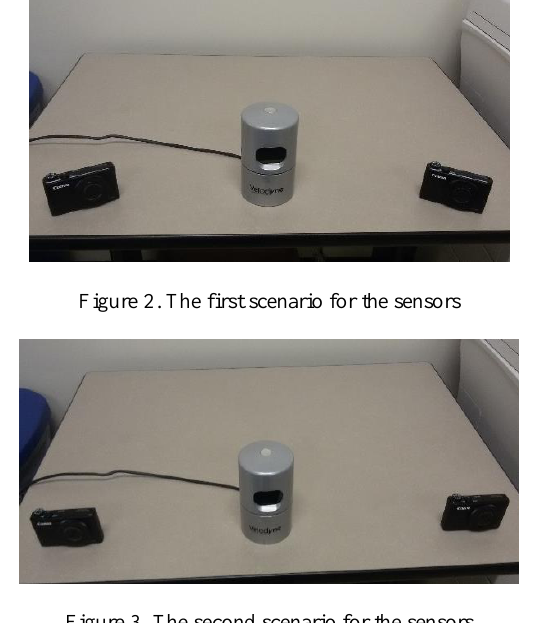
Figure 3. The second scenario for the sensors